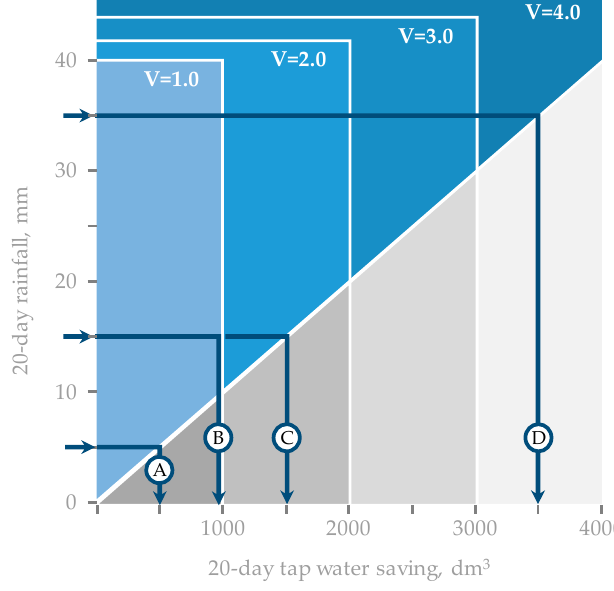
Figure 5. Ideal scheme of operation of rainwater tanks.